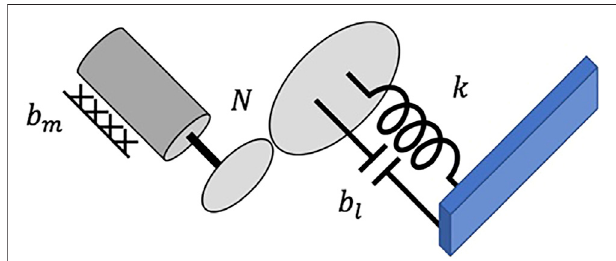
FIGURE2| Single fl exiblejoint.Inthisdiagram, b m , b l , N ,and k represent the motor damping, gear damping, gear ratio, and spring constant, respectively, and i denotes the i th